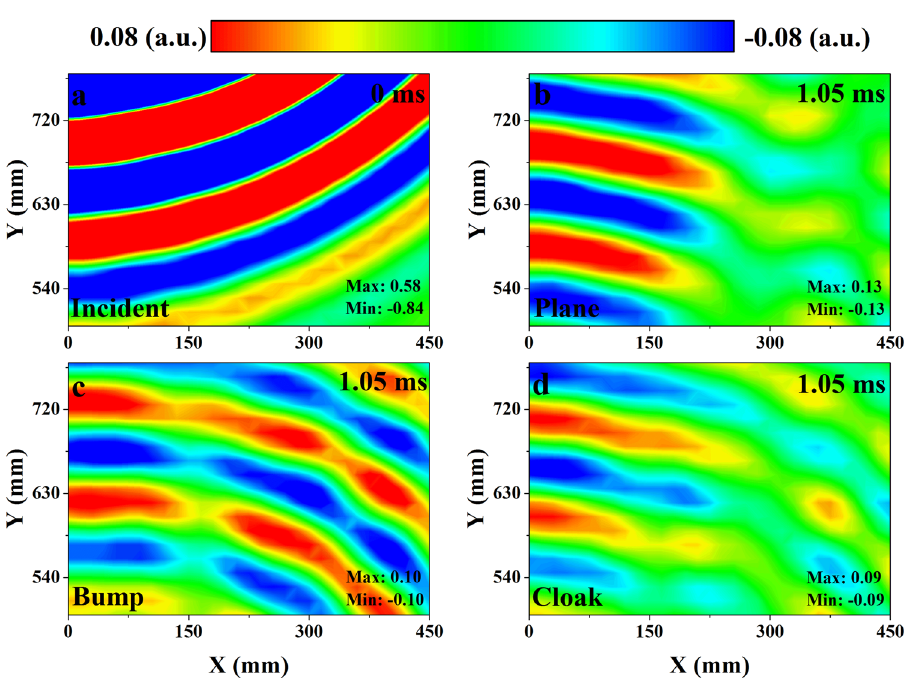
Figure 5. Measured acoustic pressure fields at 14 kHz. ( a ) The incident pulse produced by the source. The time of the incident acoustic field is set as 0 ms. ( b – d ) The scattered pressure fields measured after 1.05 ms. The short Gaussian pulse is reflected from the ( b ) soft plane, ( c ) soft bump and ( d ) soft bump covered by carpet cloak